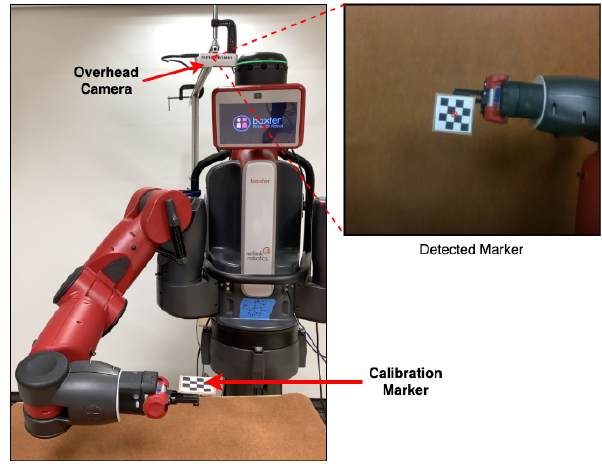
Figure 12. Setup for hand-eye calibration procedure.